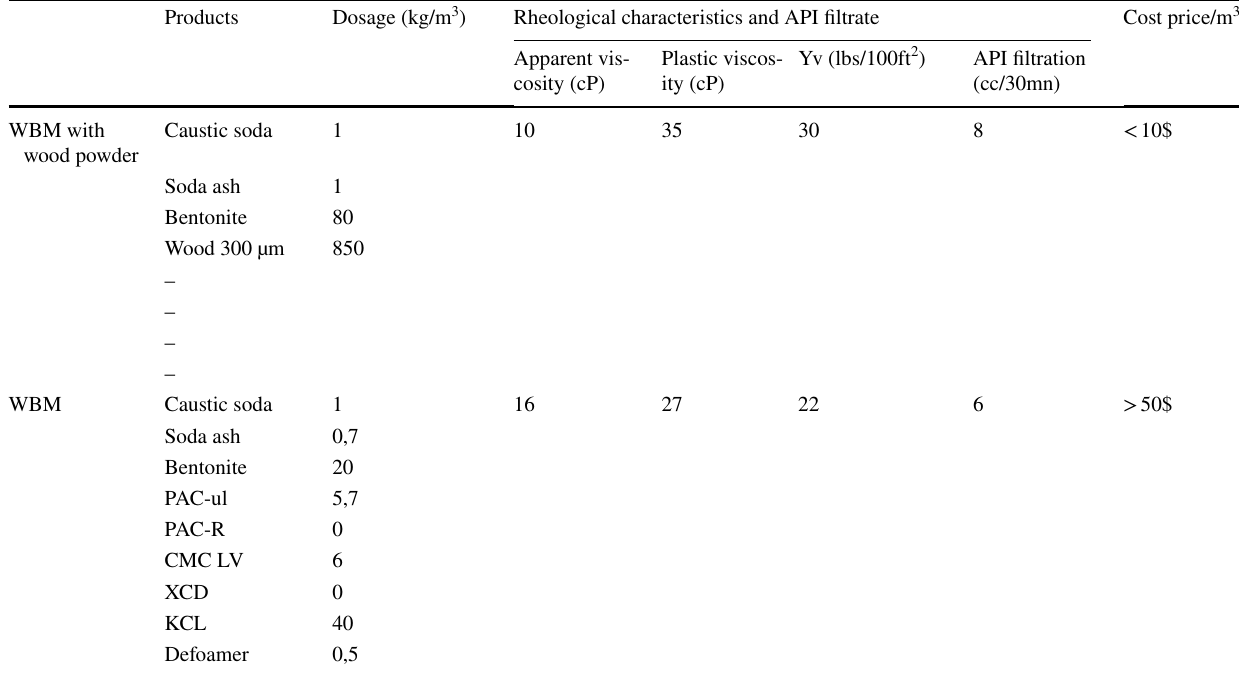
Table 2 Rheological characteristics, API filtrate, and cost price of water-based